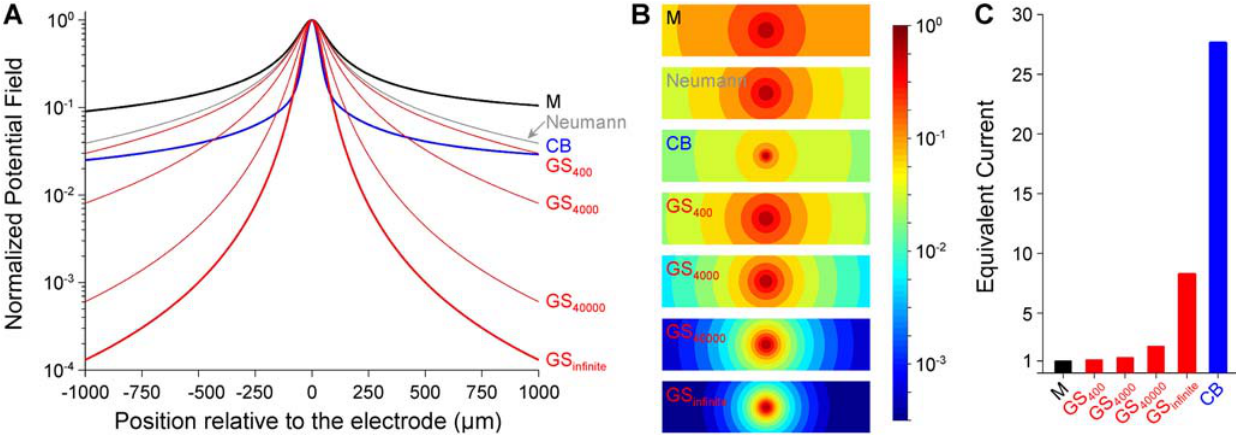
Figure 8. Improvement of the focality of the potential field with a ground surface configuration. The normalized potential field ( V norm ) is plotted along a line passing 50 m m over the electrodes ( A ), and mapped over the z =50 m m horizontal plane ( B ). The offset values were: 0 mV for the monopolar configuration and the concentric bipolar configuration, and 0.027, 0.00044, 0.0000026, and 0 mV for the ground surface configuration, when using Robin boundary conditions with g GS =400, 4000, 40000 S/m 2 , and infinite. The maps cover a distance of 1000 (respectively 250) m m on both sides of the stimulation electrode, in the x (respectively y ) direction. The three electrode configurations presented in Figure 3 are considered: Monopolar (M), Concentric Bipolar (CB) and Ground Surface (GS). For this latter configuration, the surface conductance g GS was assigned four different values: 400, 4000, 40000 S/m 2 , and infinite. We also characterized the focality obtained using non homogeneous Neumann BC (Equation 13), which corresponds to a very low conductance of the ground surface. For a nominal current of 1 m A, the maximum potential field was 1.99 mV 50 m m above the planar disk electrode in the case of a monopolar configuration. Panel C shows the equivalent current required to reach the same potential amplitude with each configuration.